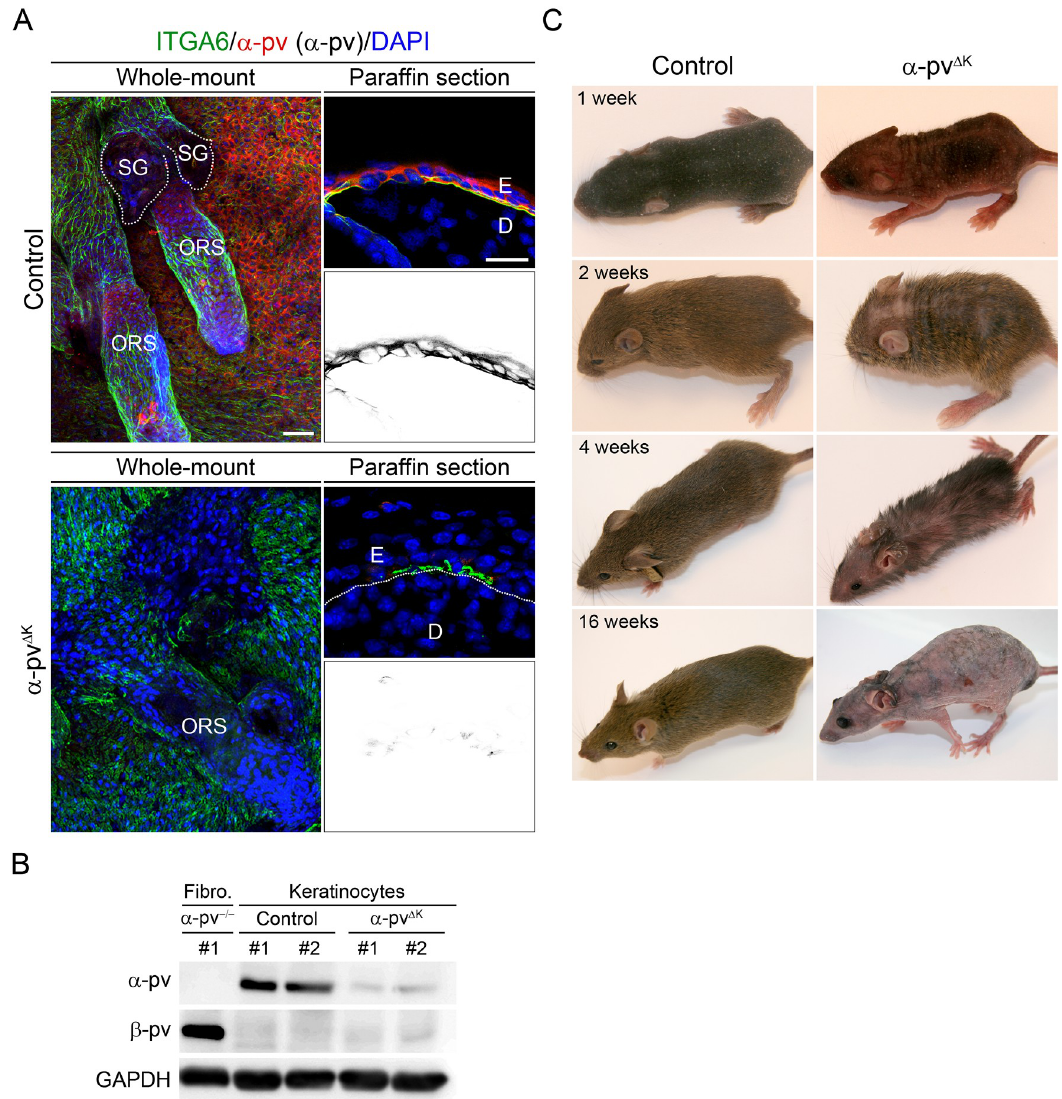
Fig 1. Keratinocyte-restricted deletion of α -pv results in progressive and persistent hair loss. ( A ) Tail-skin of 8-week-old (would- mount) and back-skin of 2-week-old (paraffin section) control and α -pv Δ K mice stained for α -pv and α 6 integrin. Scale bars are 40 μ m and 20 μ m, respectively. E: epidermis, D: dermis, ORS: outer-root-sheath and SG: sebaceous gland. Note the expression of α - pv in basal keratinocytes of interfollicular epidermis and ORS, and the strong reduction in the α -pv signal in α -pv Δ K mice when compared to control mice. ( B ) Protein levels of α -pv and β -pv in keratinocyte lysates of control and α -pv Δ K mice and in fibroblast (fibro) lysates isolated from α -pv -/- mice [11]. ( C ) Gross morphology analysis of control and α -pv Δ K mice at indicated time points.